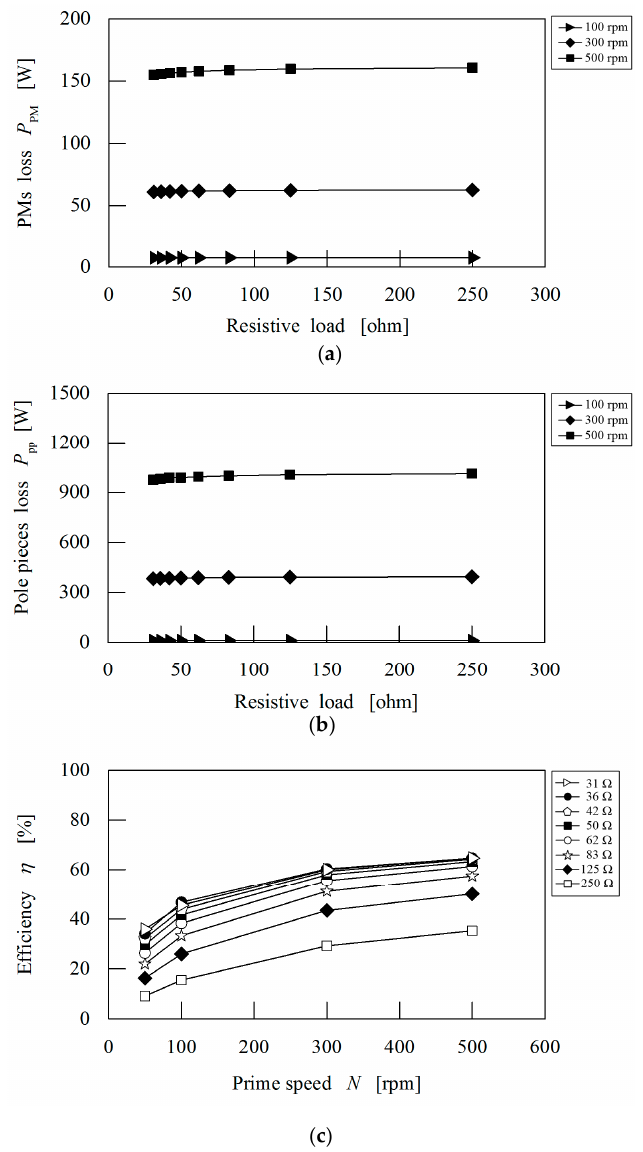
Figure 8. Permanent magnets and pole piece losses as a function of resistive load at various speeds with efficiency: ( a ) Permanent magnets losses; ( b ) Pole piece losses; ( c )